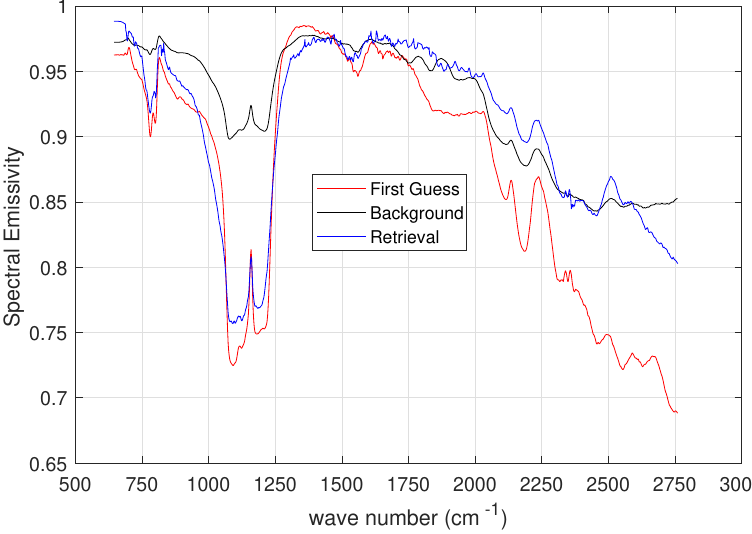
Figure 11. Example of emissivity retrieval corresponding to one of the IASI soundings in Figure